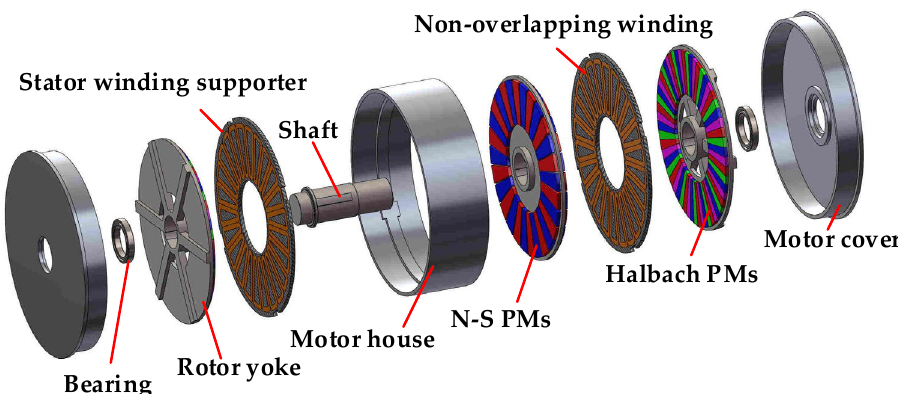
Figure 1. The basic structure of the SCM-AFPM motor.